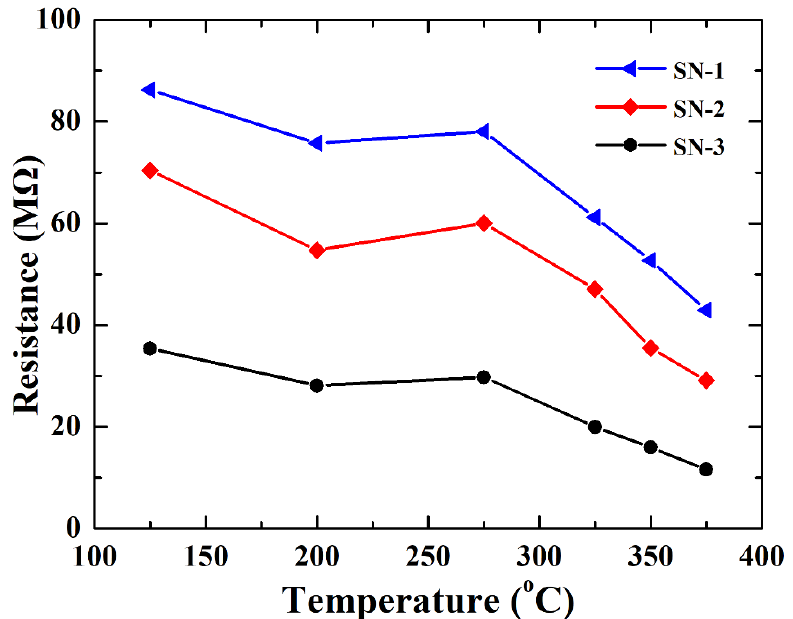
Figure 9. Working temperature dependence of resistance of SnO 2 -based gas sensor in air.